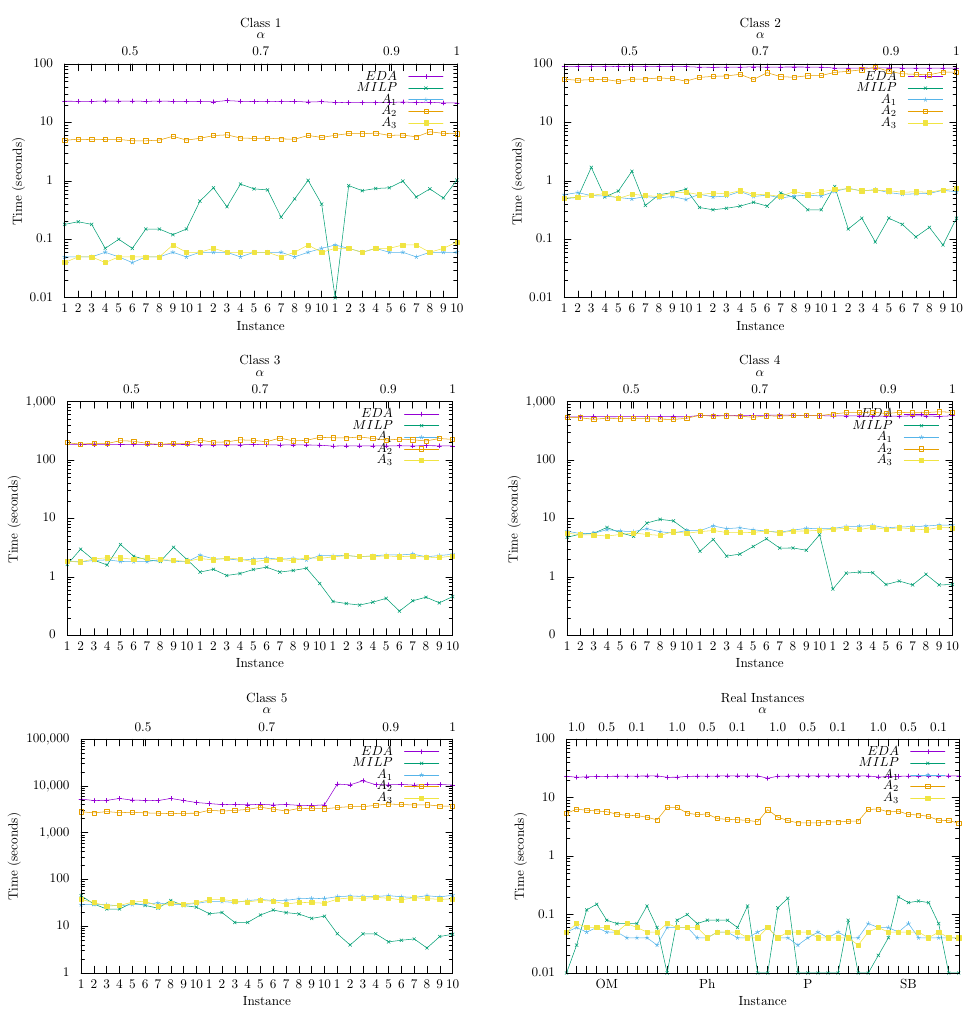
Figure 8. The runtime of MILP-based solution, EDA-based solution, and our approach in the three different versions (named A 1 , A 2 , and A 3